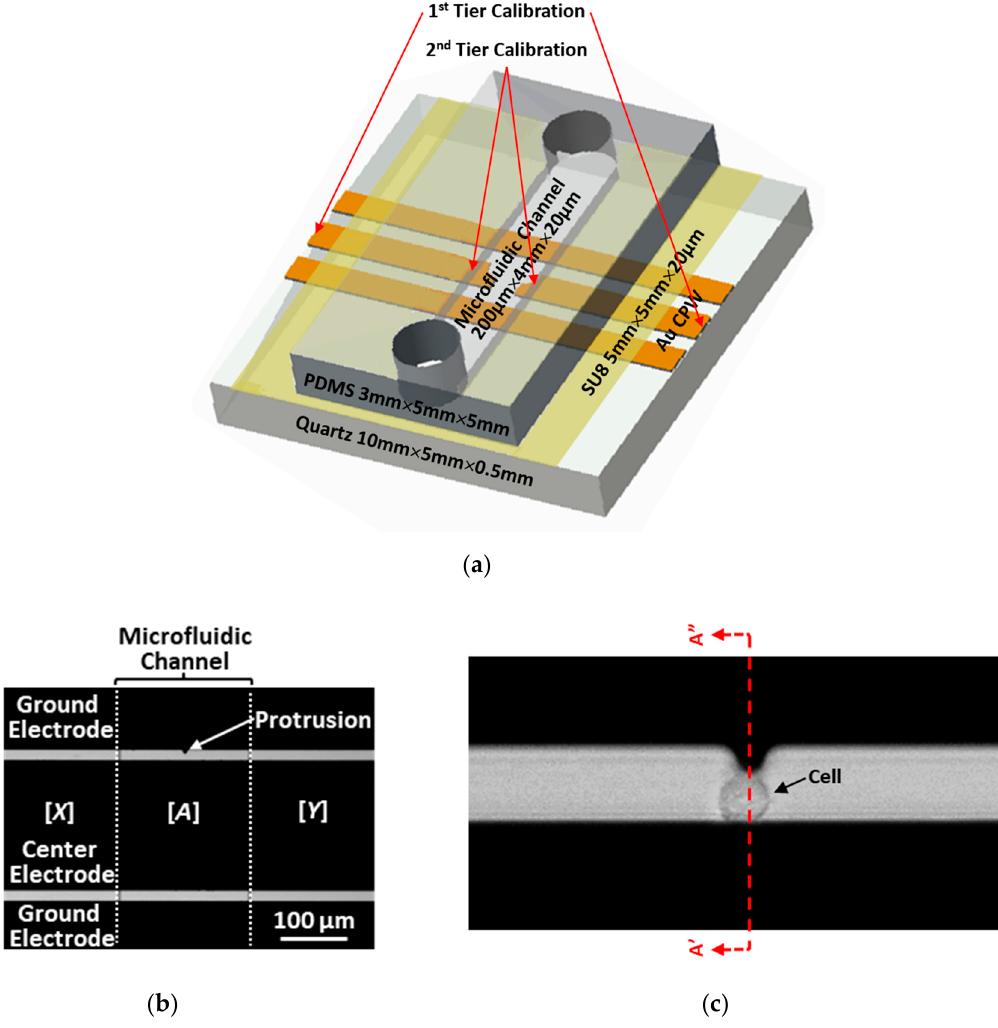
Figure 1. ( a ) Schematic illustration of the test chip comprising a microfluidic channel intersecting a coplanar waveguide (CPW) at a right angle. ( b ) Micrograph showing one of the ground electrodes of the CPW has a protrusion in the middle. ( c ) High-magnification micrograph showing a cell trapped by dielectrophoresis (DEP) at the tip of the protrusion.